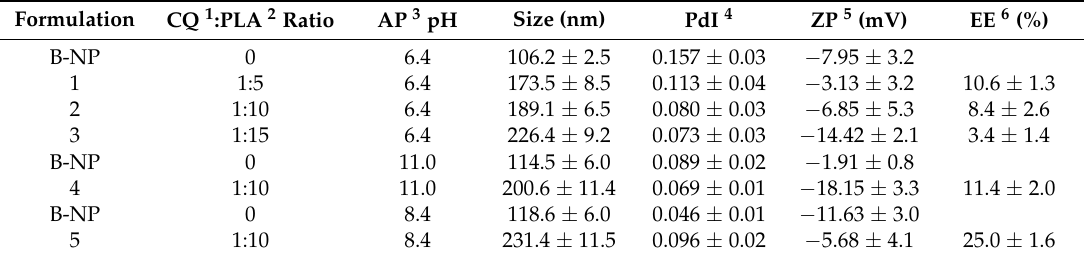
Table 1. Physicochemical properties of blank nanoparticles (B-NP) and respective CQ-NP produced by the nanoprecipitation